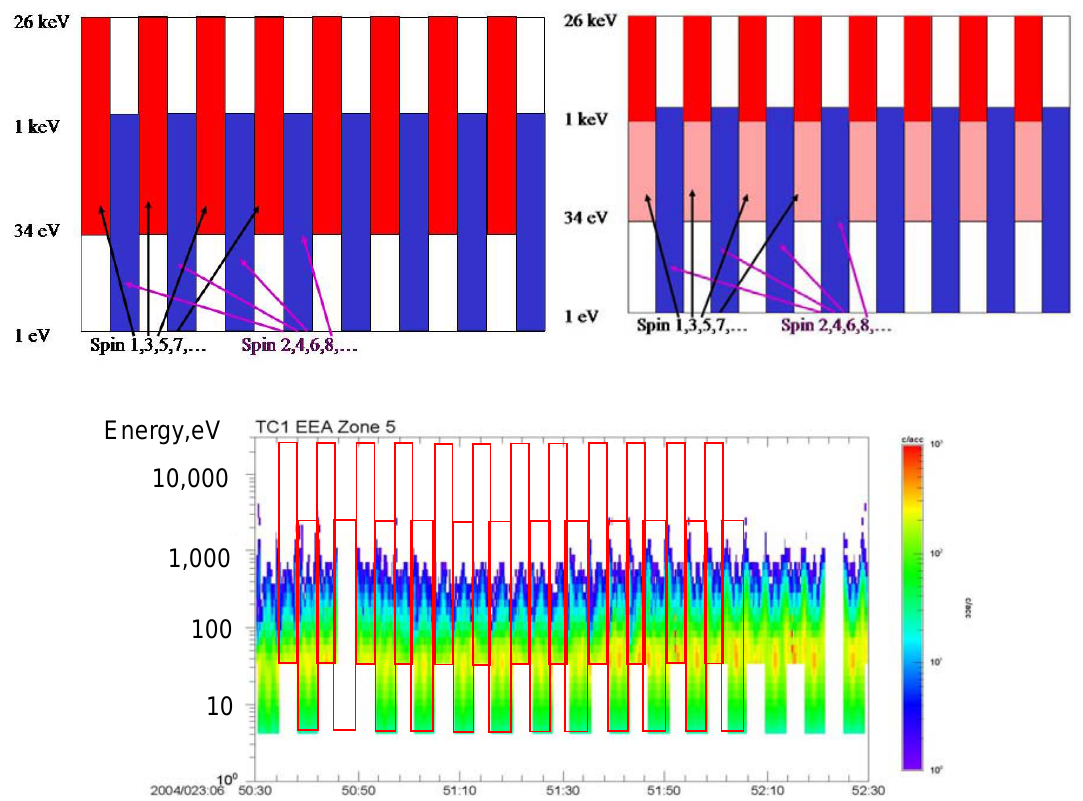
Figure 11. (a) illustration of alternating preset mode; (b) illustration of option of returning only non-overlapping energy data from first sweep in a pair;(c) data plot showing coverage when operating as in mode outlined in (a).